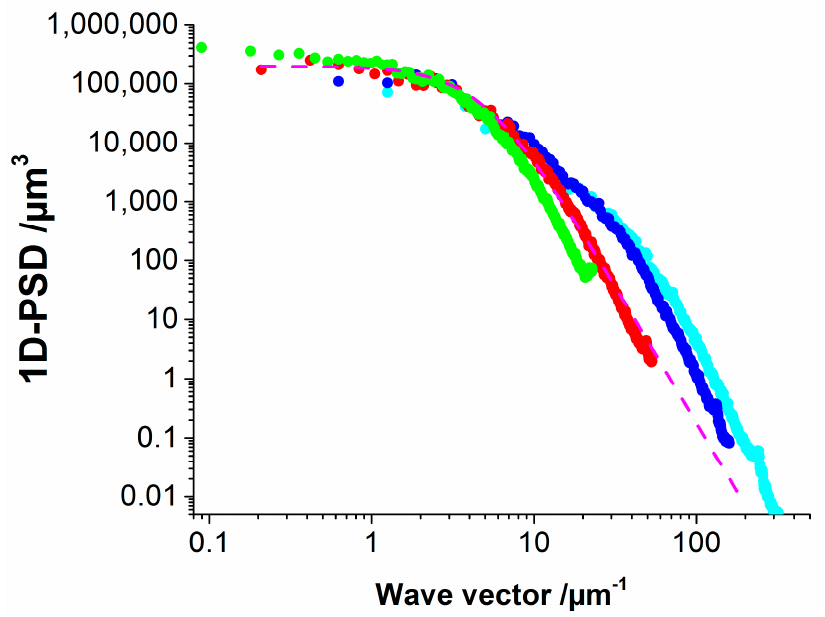
Figure 3. One-dimensional power spectral density of an SFMO thin film deposited by ceramic target magnetron sputtering and crystallized at 900 °C (dots) in comparison with the ABC model, Equation (8) (dotted line). AFM scans were carried out at one point using scanning areas of 5 × 5 µ m 2 (light blue), 10 × 10 µ m 2 (blue), 30 × 30 µ m 2 (red) and 70 × 70 µ m 2